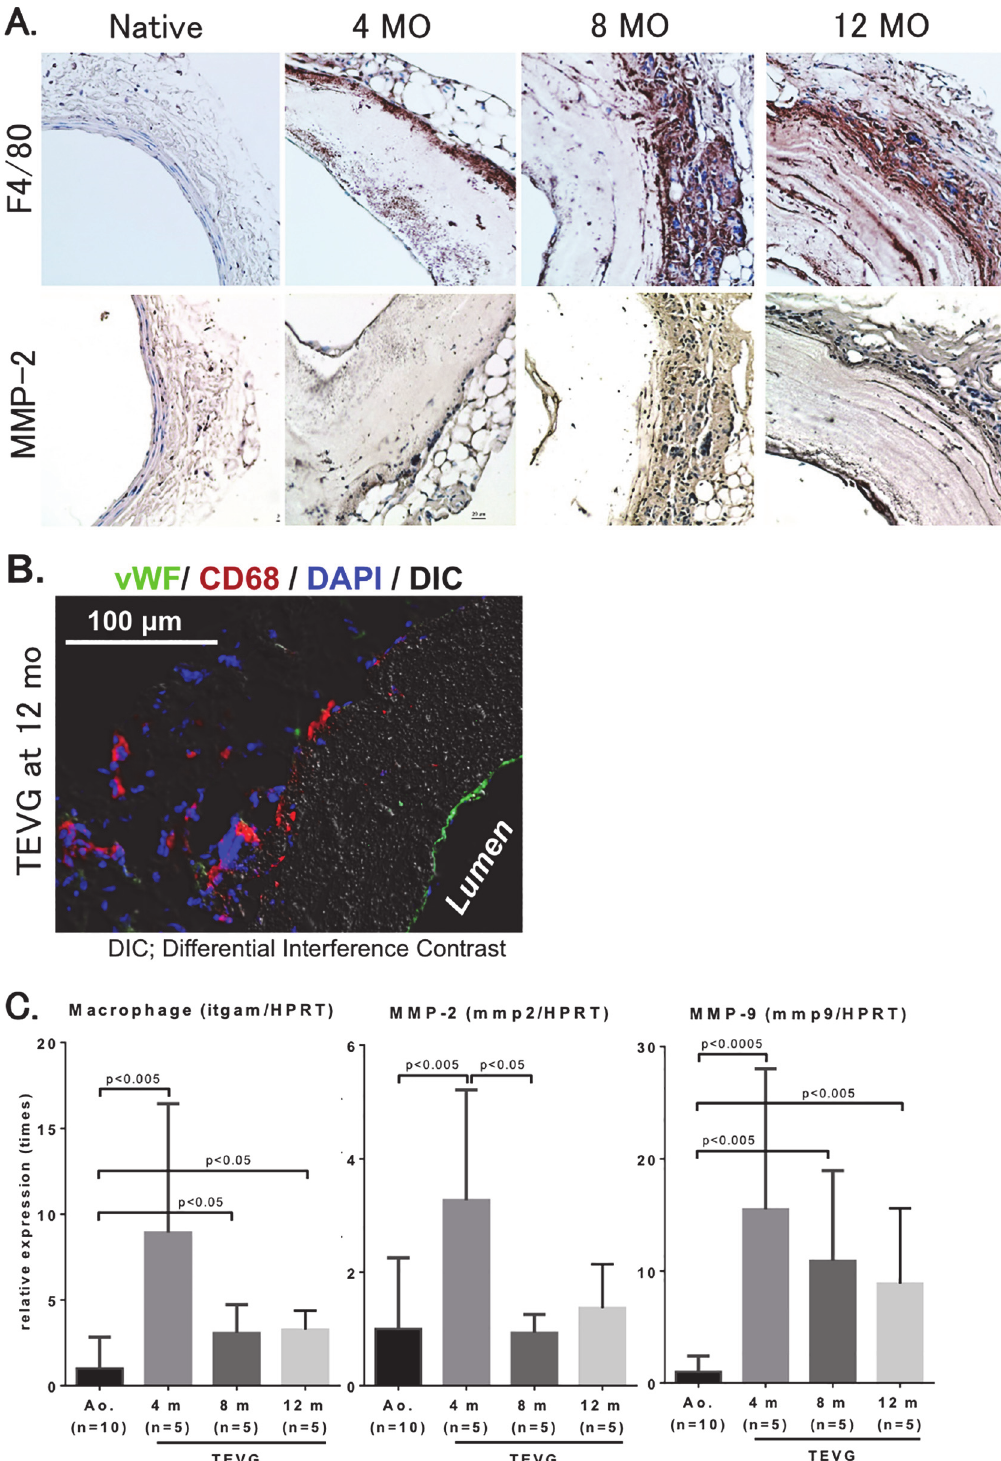
Fig 6. Macrophage infiltration and matrix metalloproteinase activity peaked at 4 months after implantation of TEVG. A. Immunohistochemical analysis of macrophage and matrix metalloproteinase-2 (MMP-2) levels. Macrophage infiltration in TEVG was assessed by F4/80 staining, while MMP-2 staining was used for an indicator of TEVG remodeling. (n = 5 in each group). B. Endothelial layer staining delineates presence of an endothelium by von Willebrand factor (vWF, green) in implanted TEVG at 12 months after implantation. There is macrophage infiltration of the periphery of the graft (CD68,